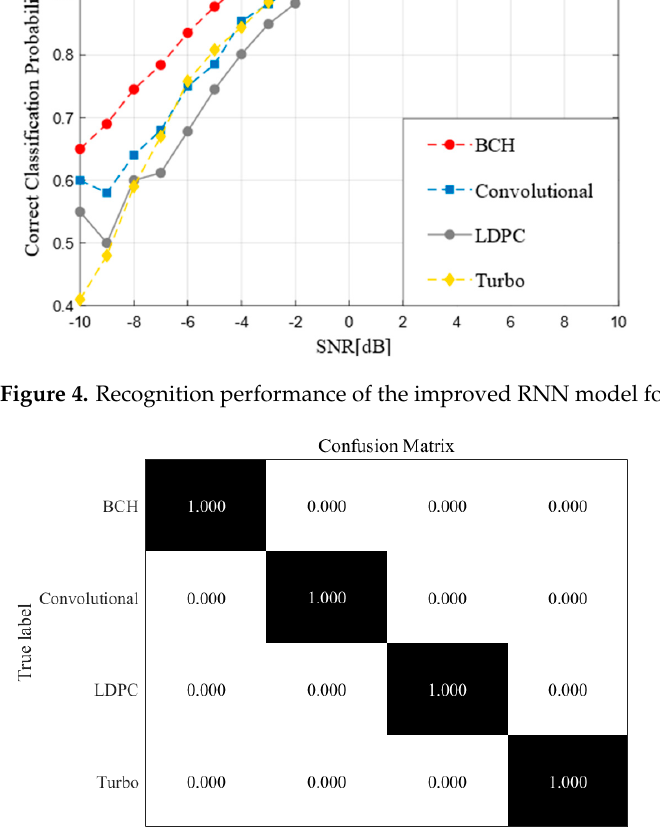
Figure 6. Confusion matrix for improved RNN trained at 0 dB SNR.